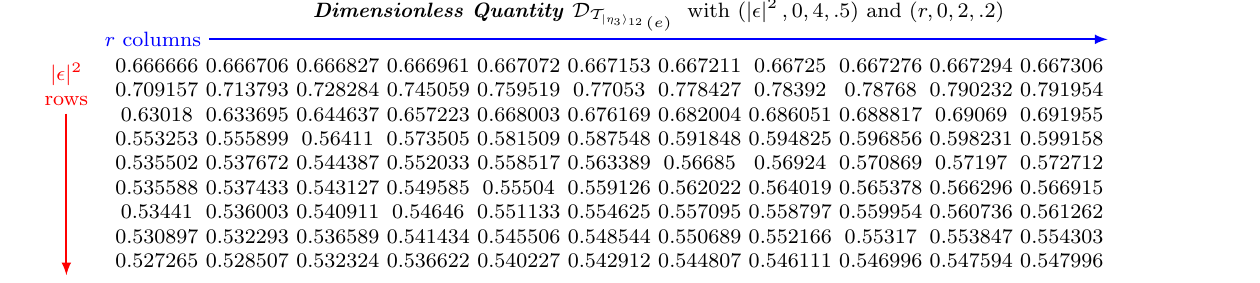
Table 10 Numerical values of D T for some range and choices of coherent and squeezing parameters. Here, | (cid:11) | 2 takes on value from 0 to 4 and r varies from 0 to